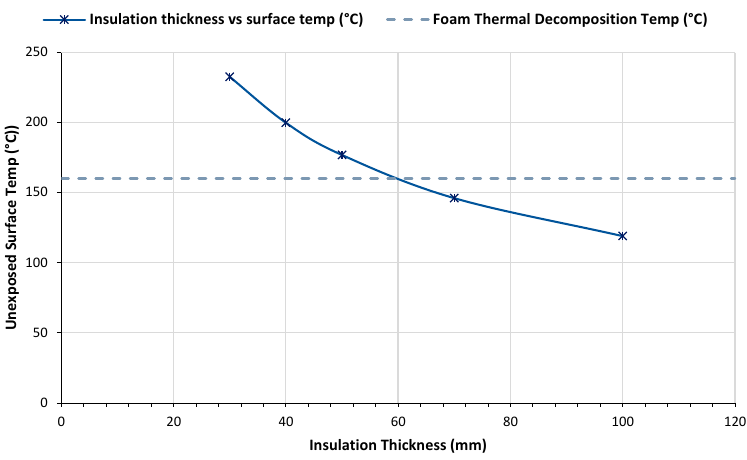
Figure 11. Insulation thickness relative to unexposed bulkhead surface temperature.